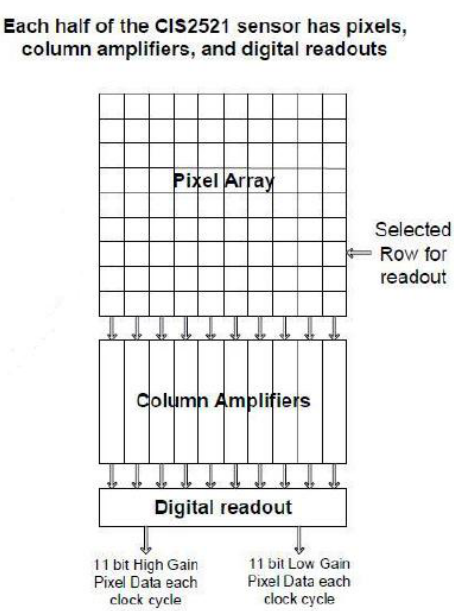
Figure 1. Block diagram of CIS2521F (Fairchild Imaging, 2015)